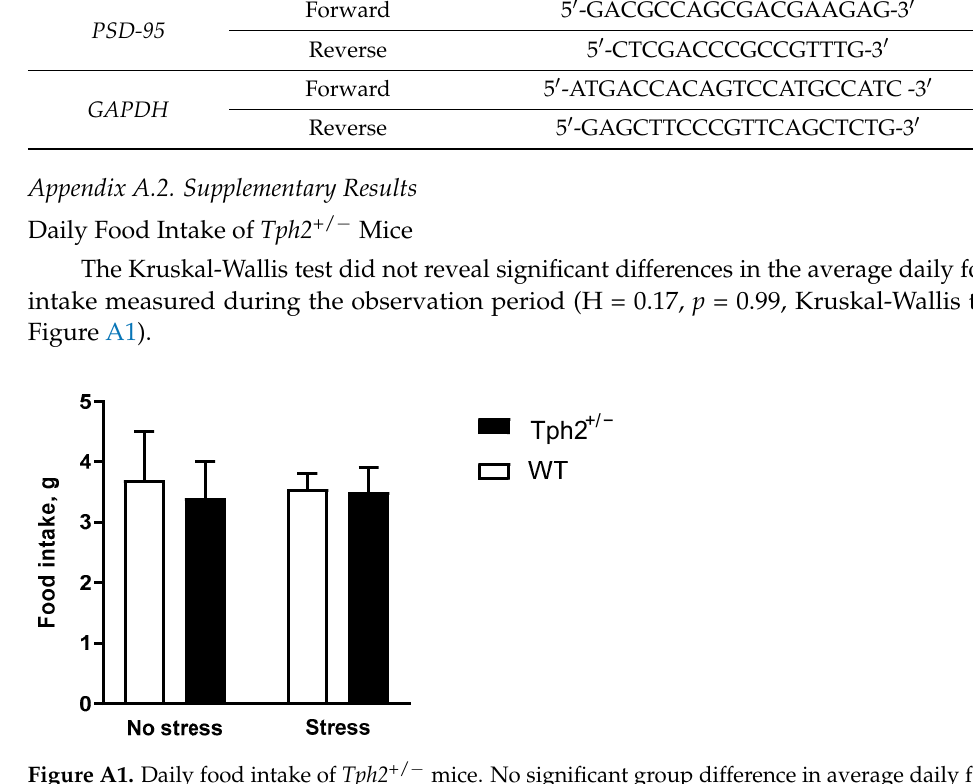
Figure A1. Daily food intake of Tph2 +/ − mice. No significant group difference in average daily food intake during the observation period was observed. WT—wild type.